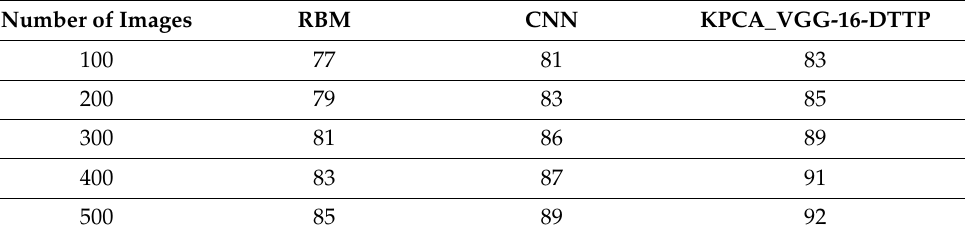
Table 3. Comparative analysis of precision.